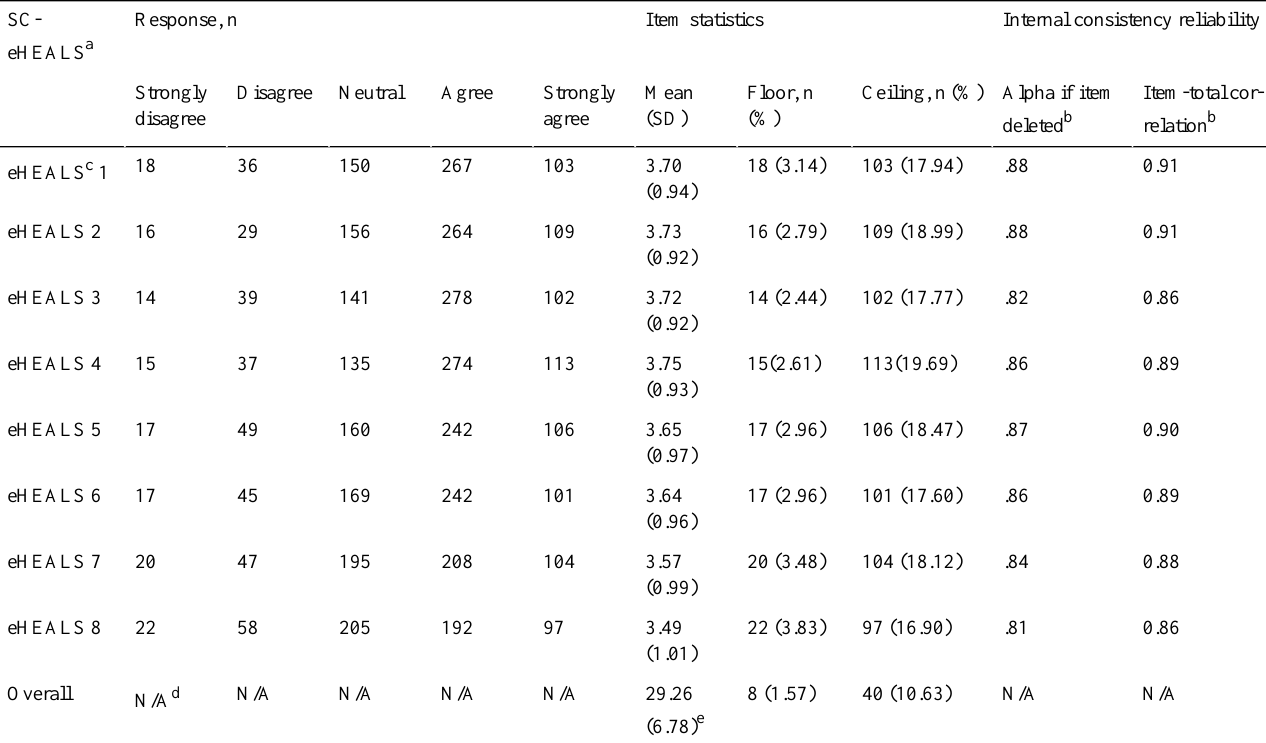
Table 5. The response pattern, item statistics, and internal consistency reliability of the simplified Chinese eHealth literacy